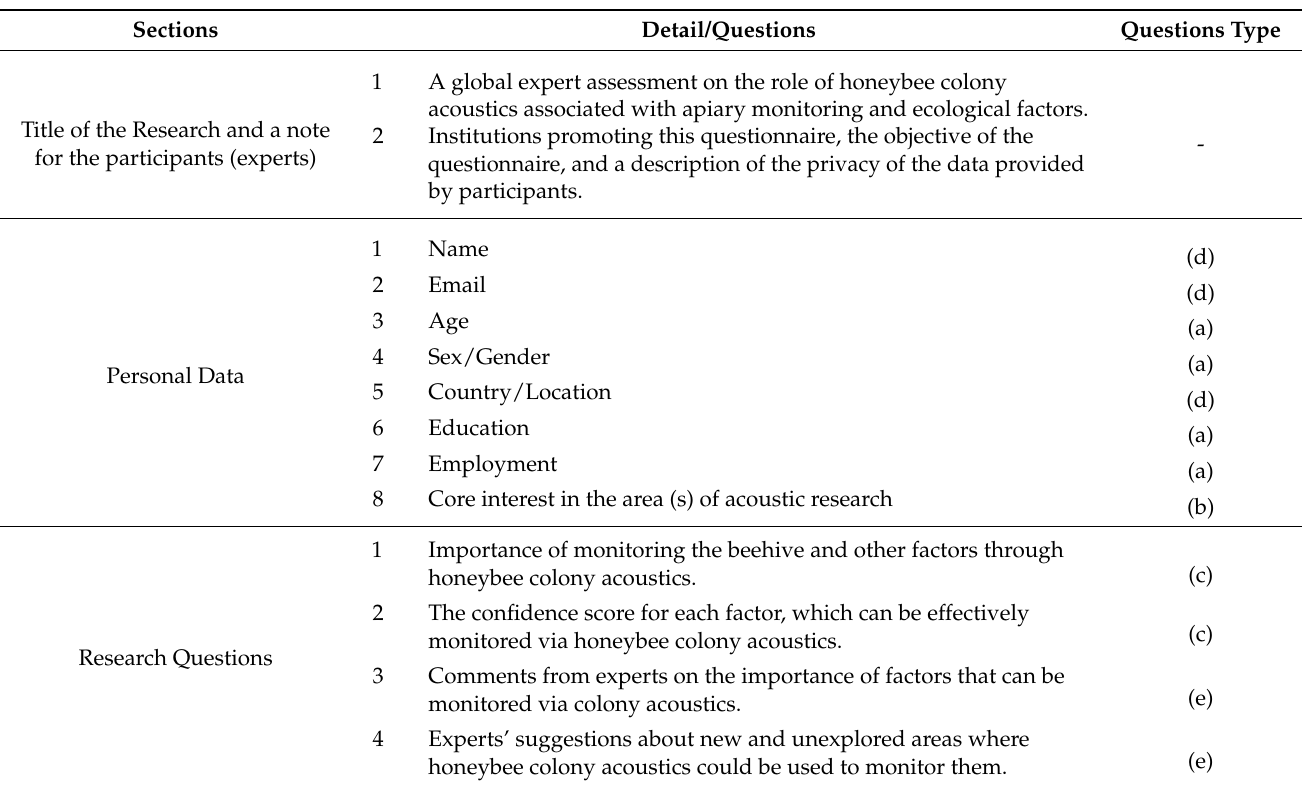
Table 1. Contents of the